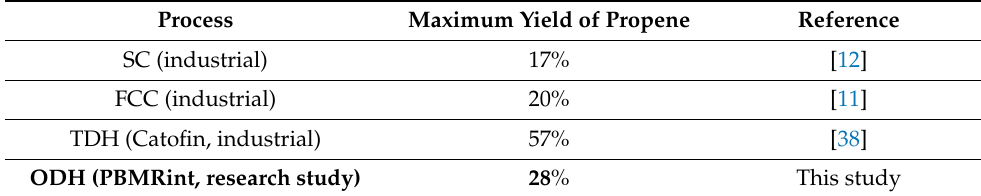
Table 5. Maximum yield of propene of different production